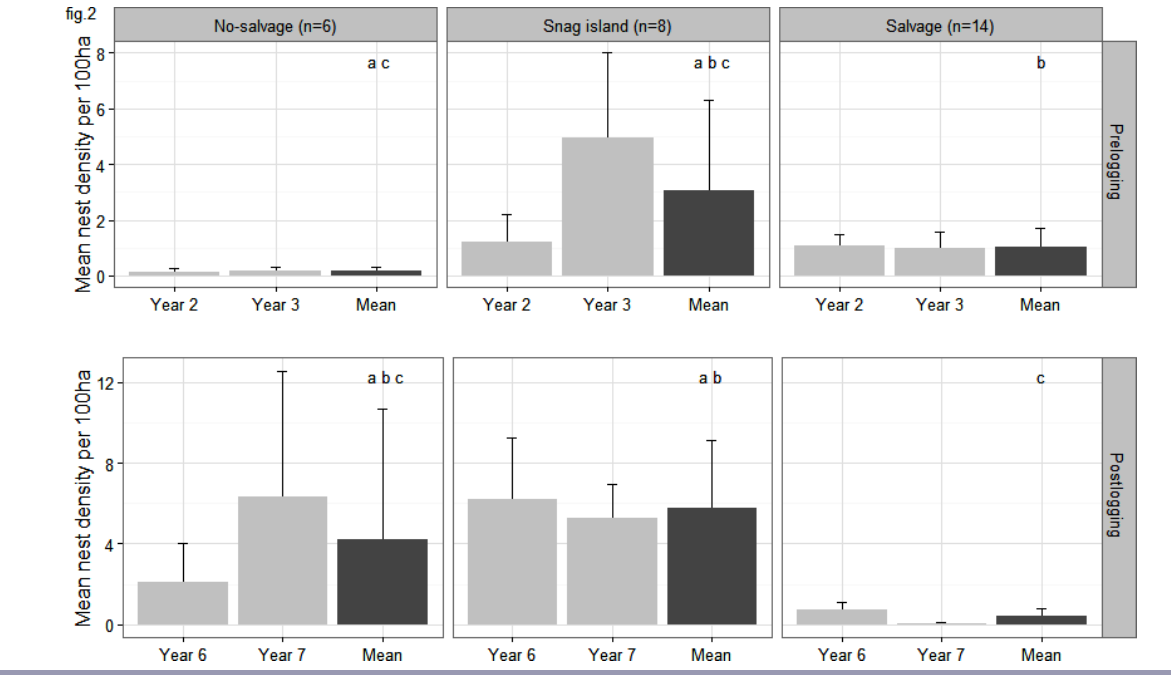
Fig. 2 . Nest densities before and after logging by treatment type. Mean nest densities before and after treatment were compared with ANOVA; bars marked with the different letters are significantly different ( α = 0.05). Lines represent 95% confidence intervals from the Poisson